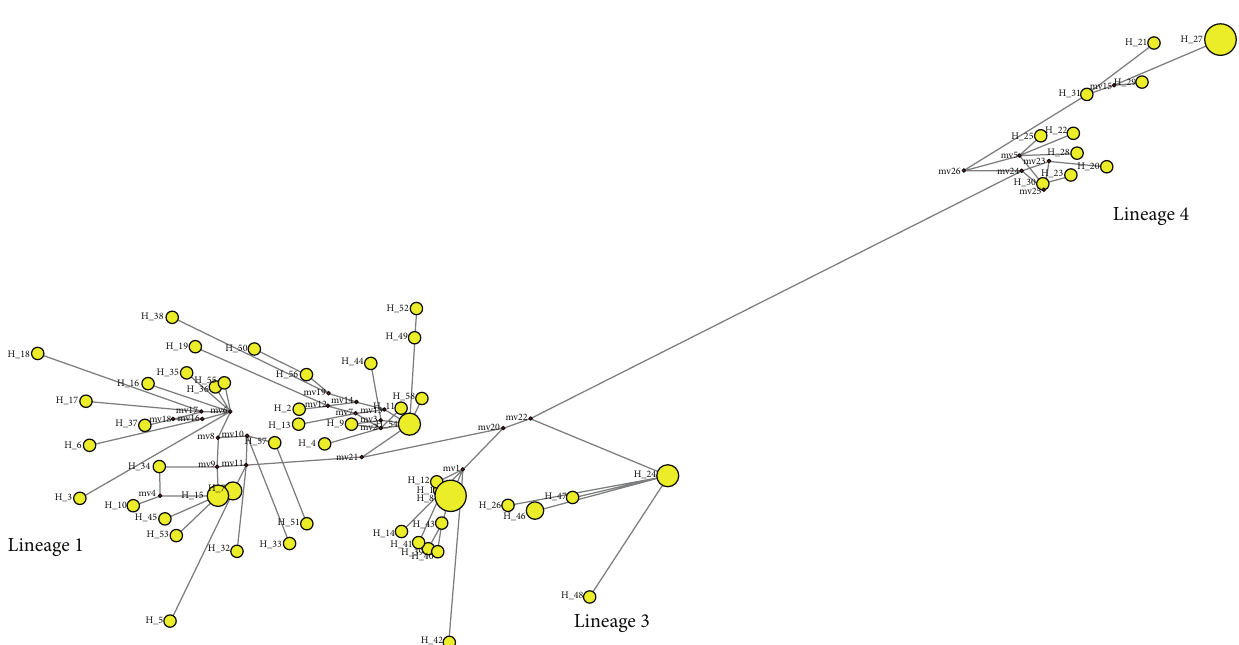
Figure 2: Minimum spanning network of T. ilisha based on D-loop haplotypes. Haplotypes separated by single lines are one mutation apart, and small circles along lines represent missing haplotypes (not sampled or extinct).